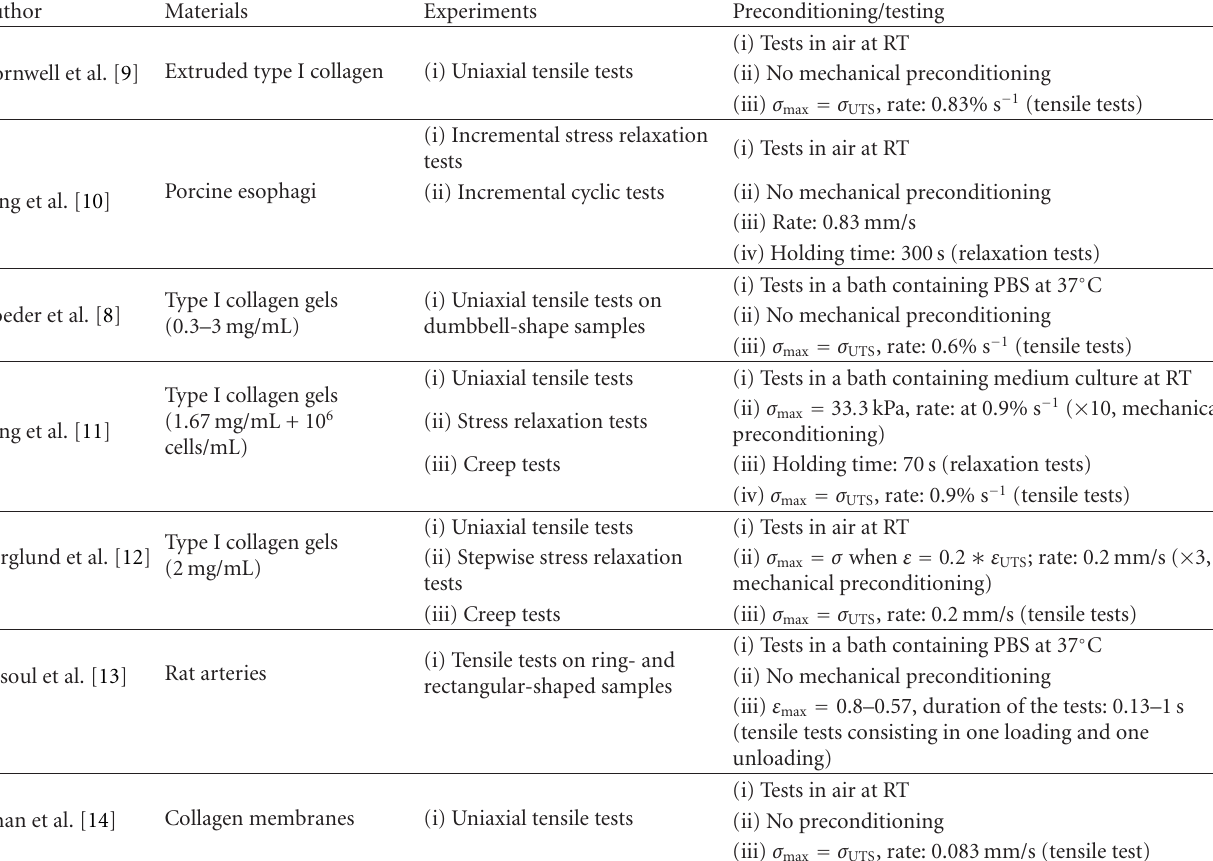
Table 1: Example of various environments of mechanical characterization of collagen materials and tissues encountered in the literature [8–14].